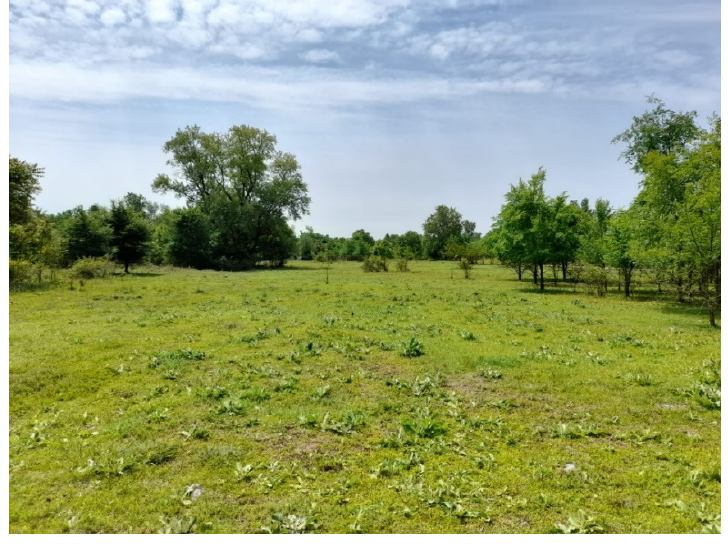
Figure 3. Malpaga-Basella Nature Reserve, station 2, with the predominance of Poaceae (photo P. Gaini).